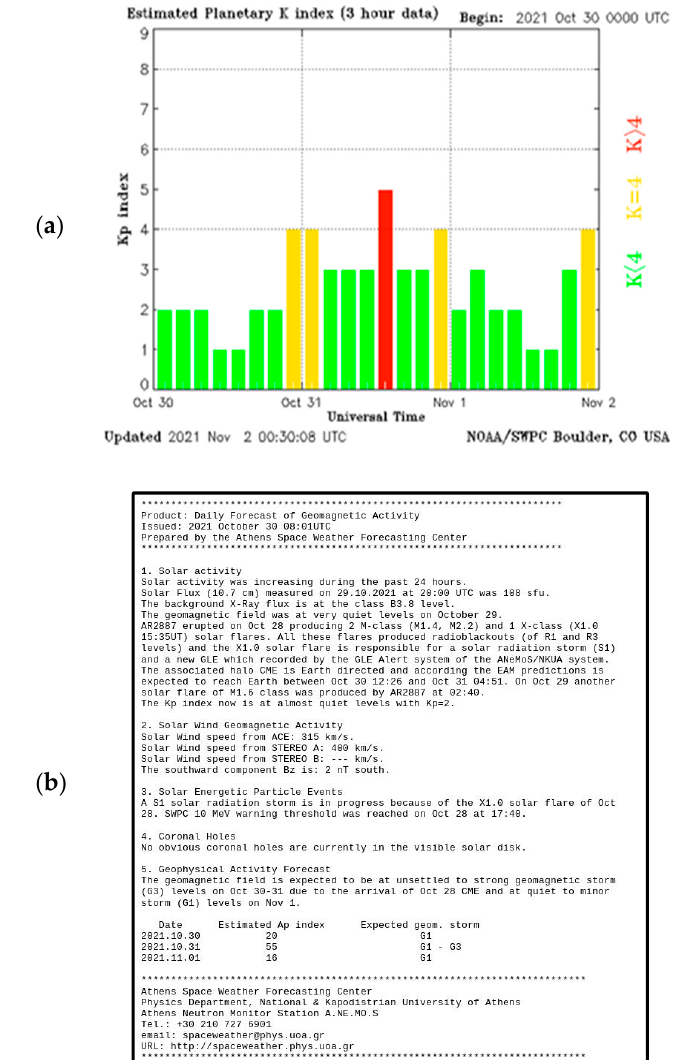
Figure 10. ( a ) Kp index variations for 30 October 2021–1 November 2021 and ( b ) the corresponding Daily Space Weather Forecasting Report from A.Ne.Mo.S. for the same time period.